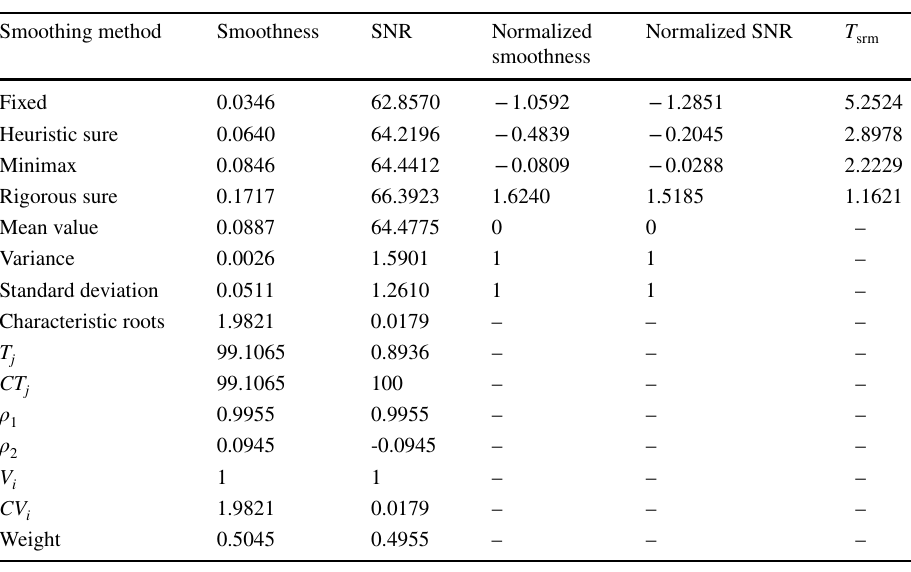
Table 2 Results of wavelet denoising and PCA